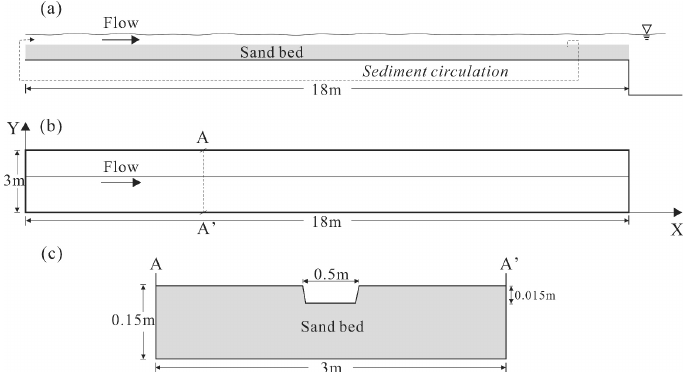
Figure 3. Schematic diagrams of the river flume: ( a ) schematic flume; ( b ) horizontal plan; and ( c ) cross-section A–A’. Table 1. Sediment fractions in the experimental river and the numerical model.